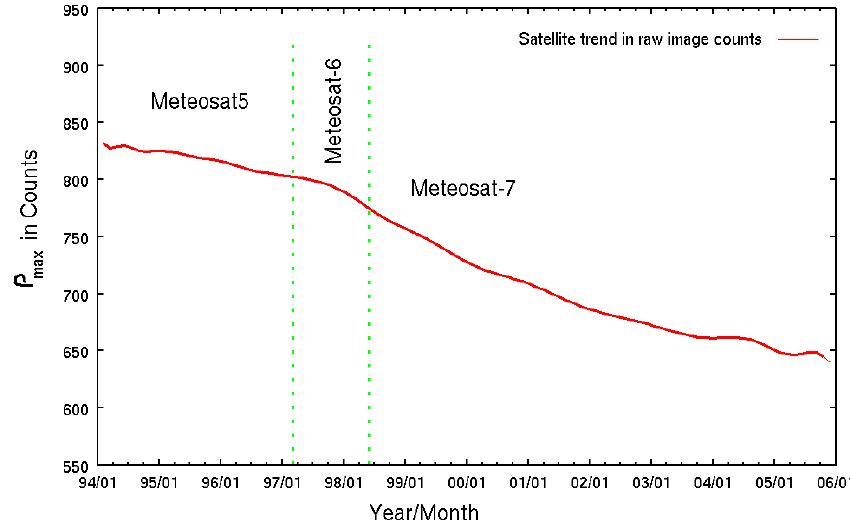
Figure 5. Temporal evolution of ρ for Meteosat-5 to Meteosat-7. A bezier fit has been max applied to the ρ values. max